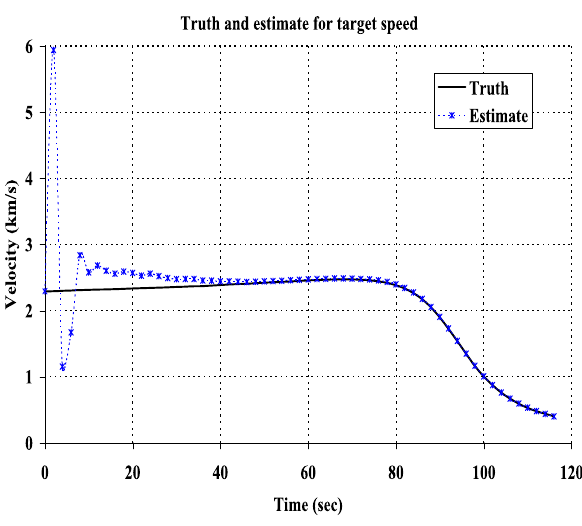
Fig. 5 Truth and estimate of RSCQKF for target